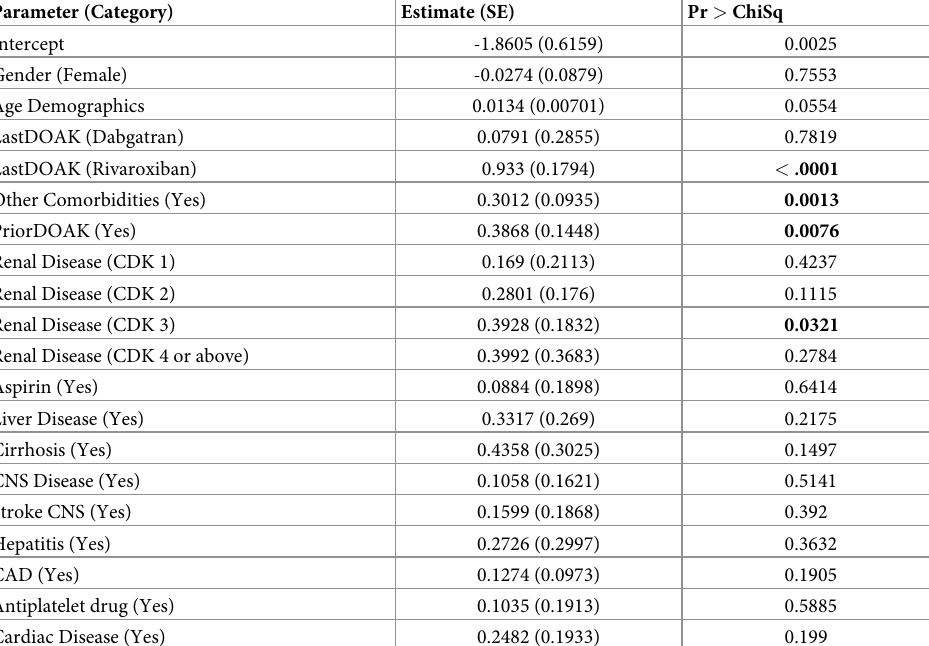
Table 5. Parameter estimates, standard error, and P-values of the final model.